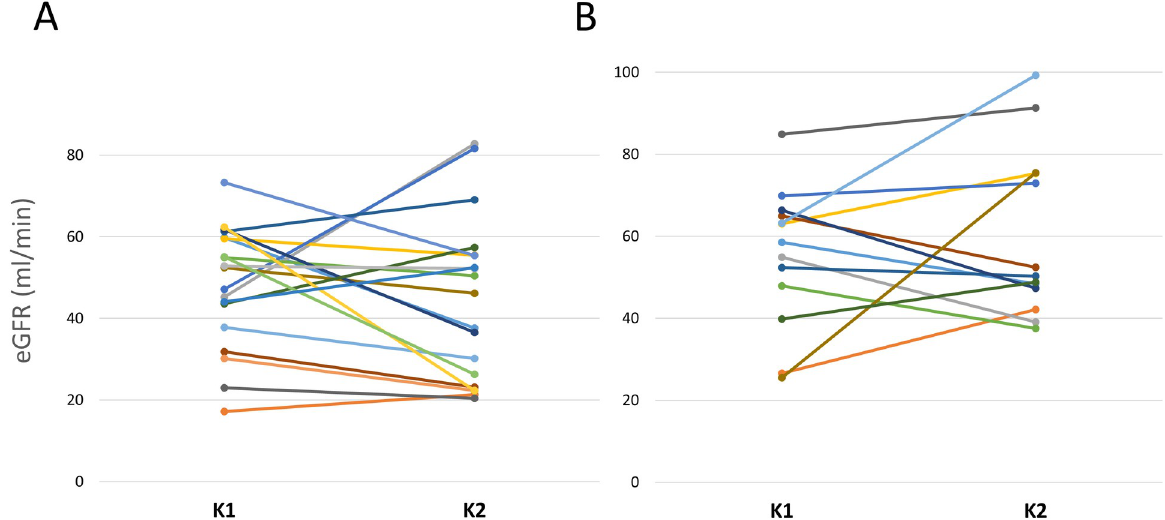
Fig 2. Estimated glomerular filtration rate (eGFR) for kidney pairs that carried (A) or did not carry (B) the CYP4F2 433M variant. K, kidney.